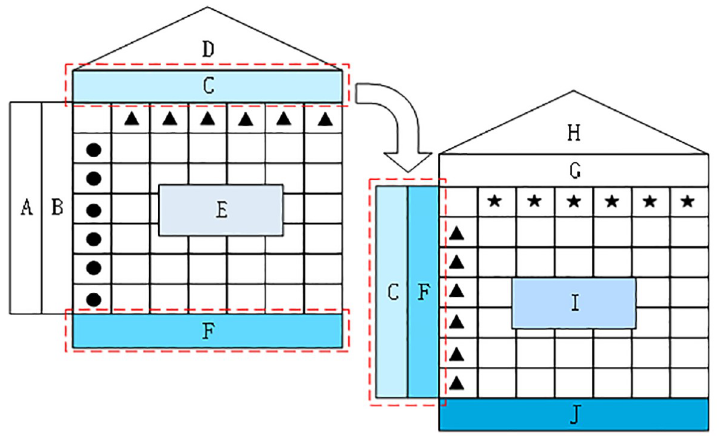
Fig 4. QFD quality model of two-stage. A: Multi-agent demand indexes. B: Satisfaction matrix of multi-agent demands. C: Engineering property indexes. D: Autocorrelation matrix of engineering property indexes. E: Correlation matrix between engineering property indexes and multi-agent demand indexes. F: Importance matrix of engineering property indexes. G: Technical property indexes. H: Autocorrelation matrix of technical property indexes. I: Correlation matrix between engineering property indexes and technical property indexes. J: Importance matrix of technical property indexes.